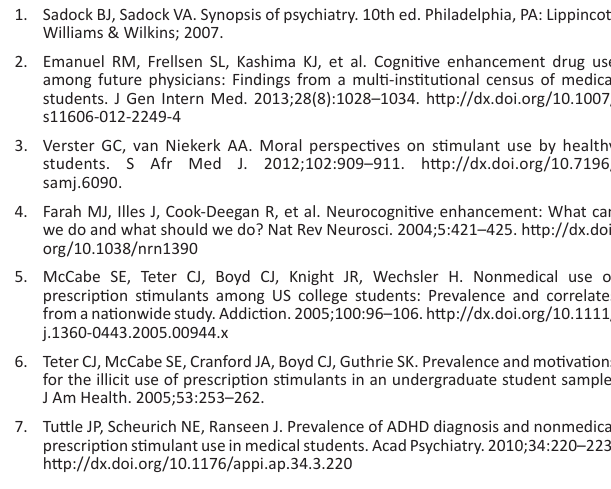
Students not diagnosed with ADHD Using stimulants Not using